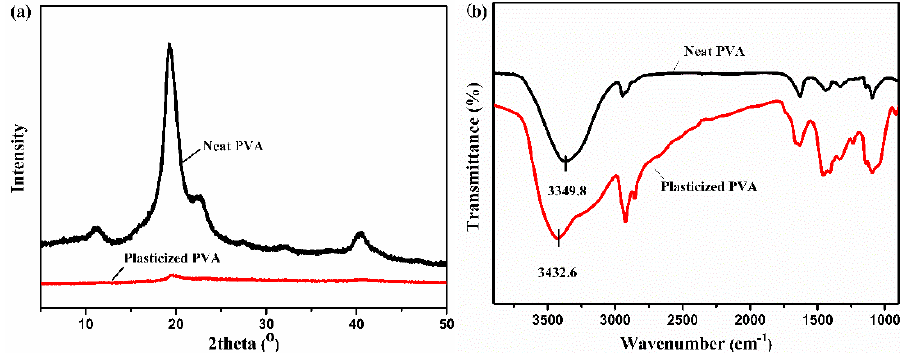
Figure 3. X-ray diffraction ( a ) and FTIR curves ( b ) of PVA powder and water-plasticized PVA